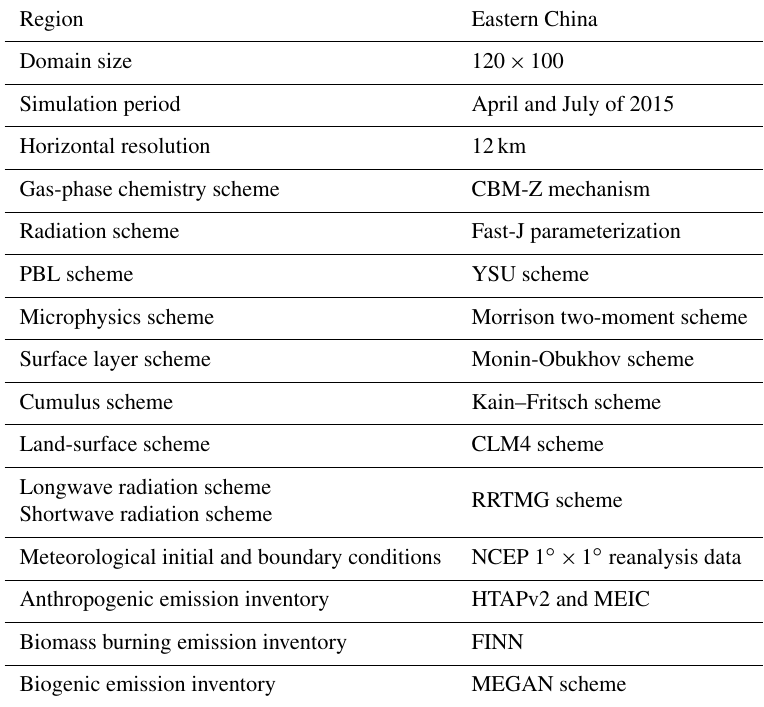
Table 1. WRF-Chem model